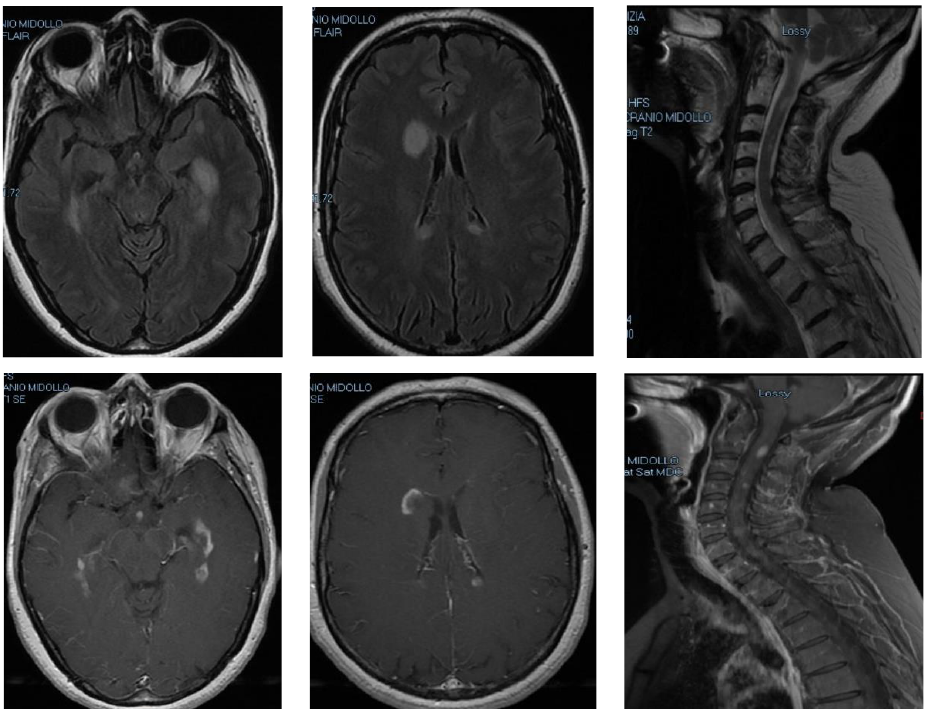
Figure 1. Case Report 1: T2-weighted sequences (top row) and T1-weighted post-gadolinium (bottom row) of brain and spinal cord MRI scan acquired at MS symptom onset.